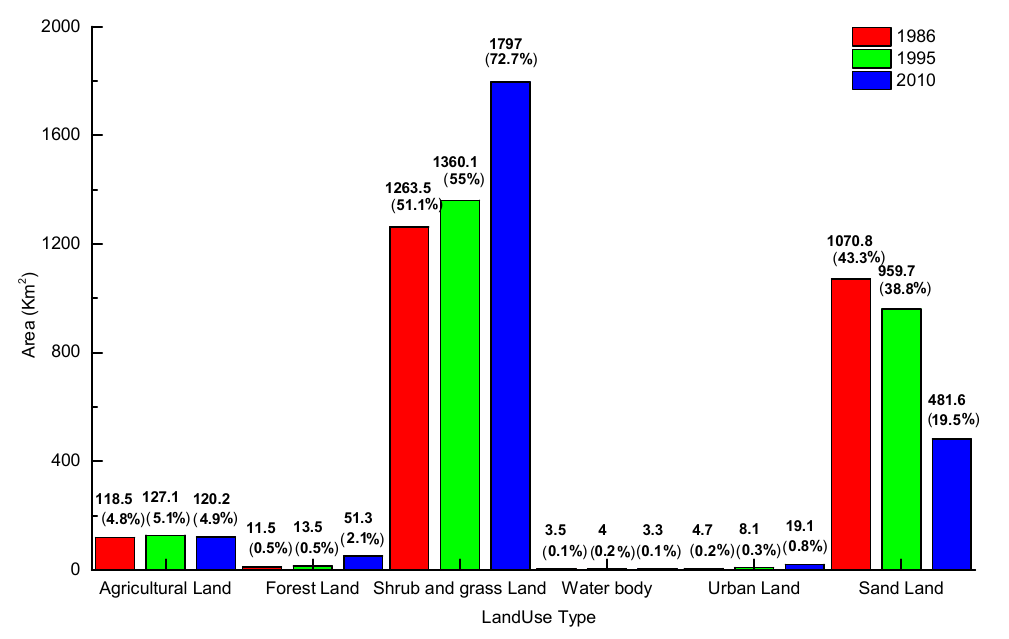
Figure 8. The variation of land used in the three eras. The values in the brackets are the percentages for each type of land use. Table 6. Transition matrix of land use changes in Hailiutu River basin over the different periods.